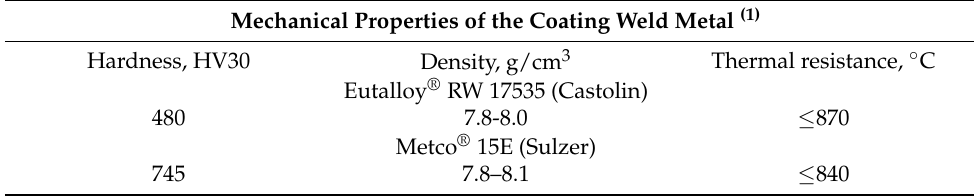
Table 3. Physical properties of the Ni-Cr-B-Si metal deposit according to the manufacturer’s data. Mechanical Properties of the Coating Weld Metal (1)